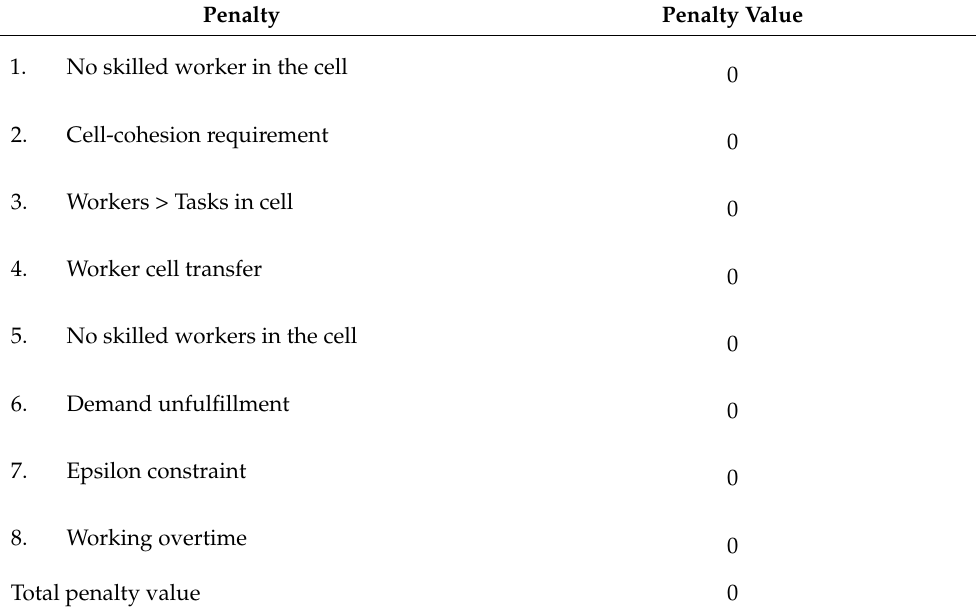
Table 11. Penalty values obtained by using two-stage ALNS for the illustrative example.